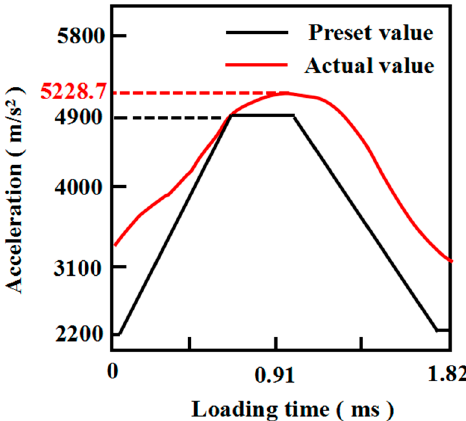
Figure 14. Loading acceleration of dropping